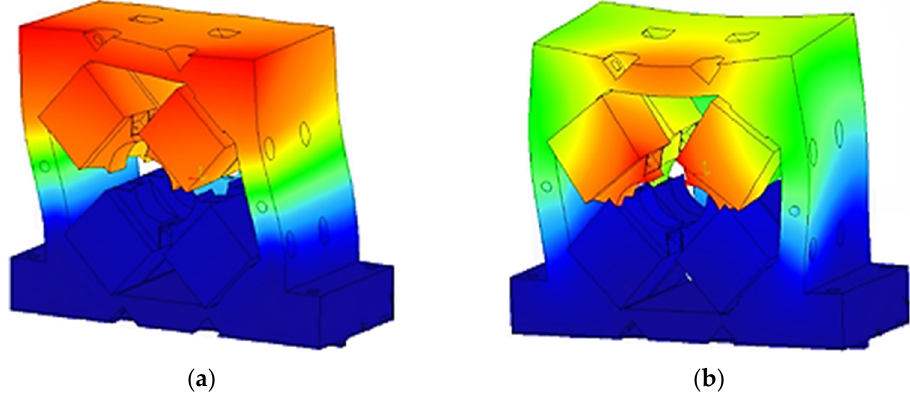
Figure 5. ( a ) First vibrational mode at 540 Hz; ( b ) second vibrational mode at 803 Hz.